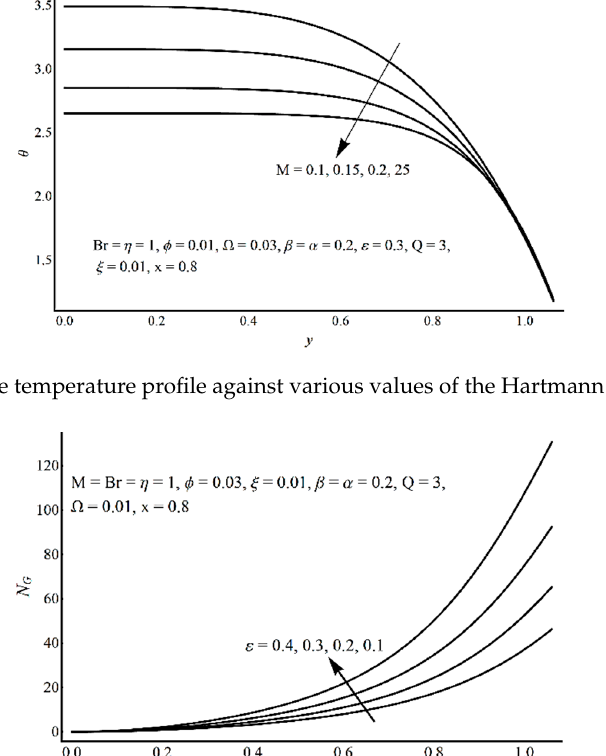
Figure 15. The temperature profile against various values of cilia length parameter ε .